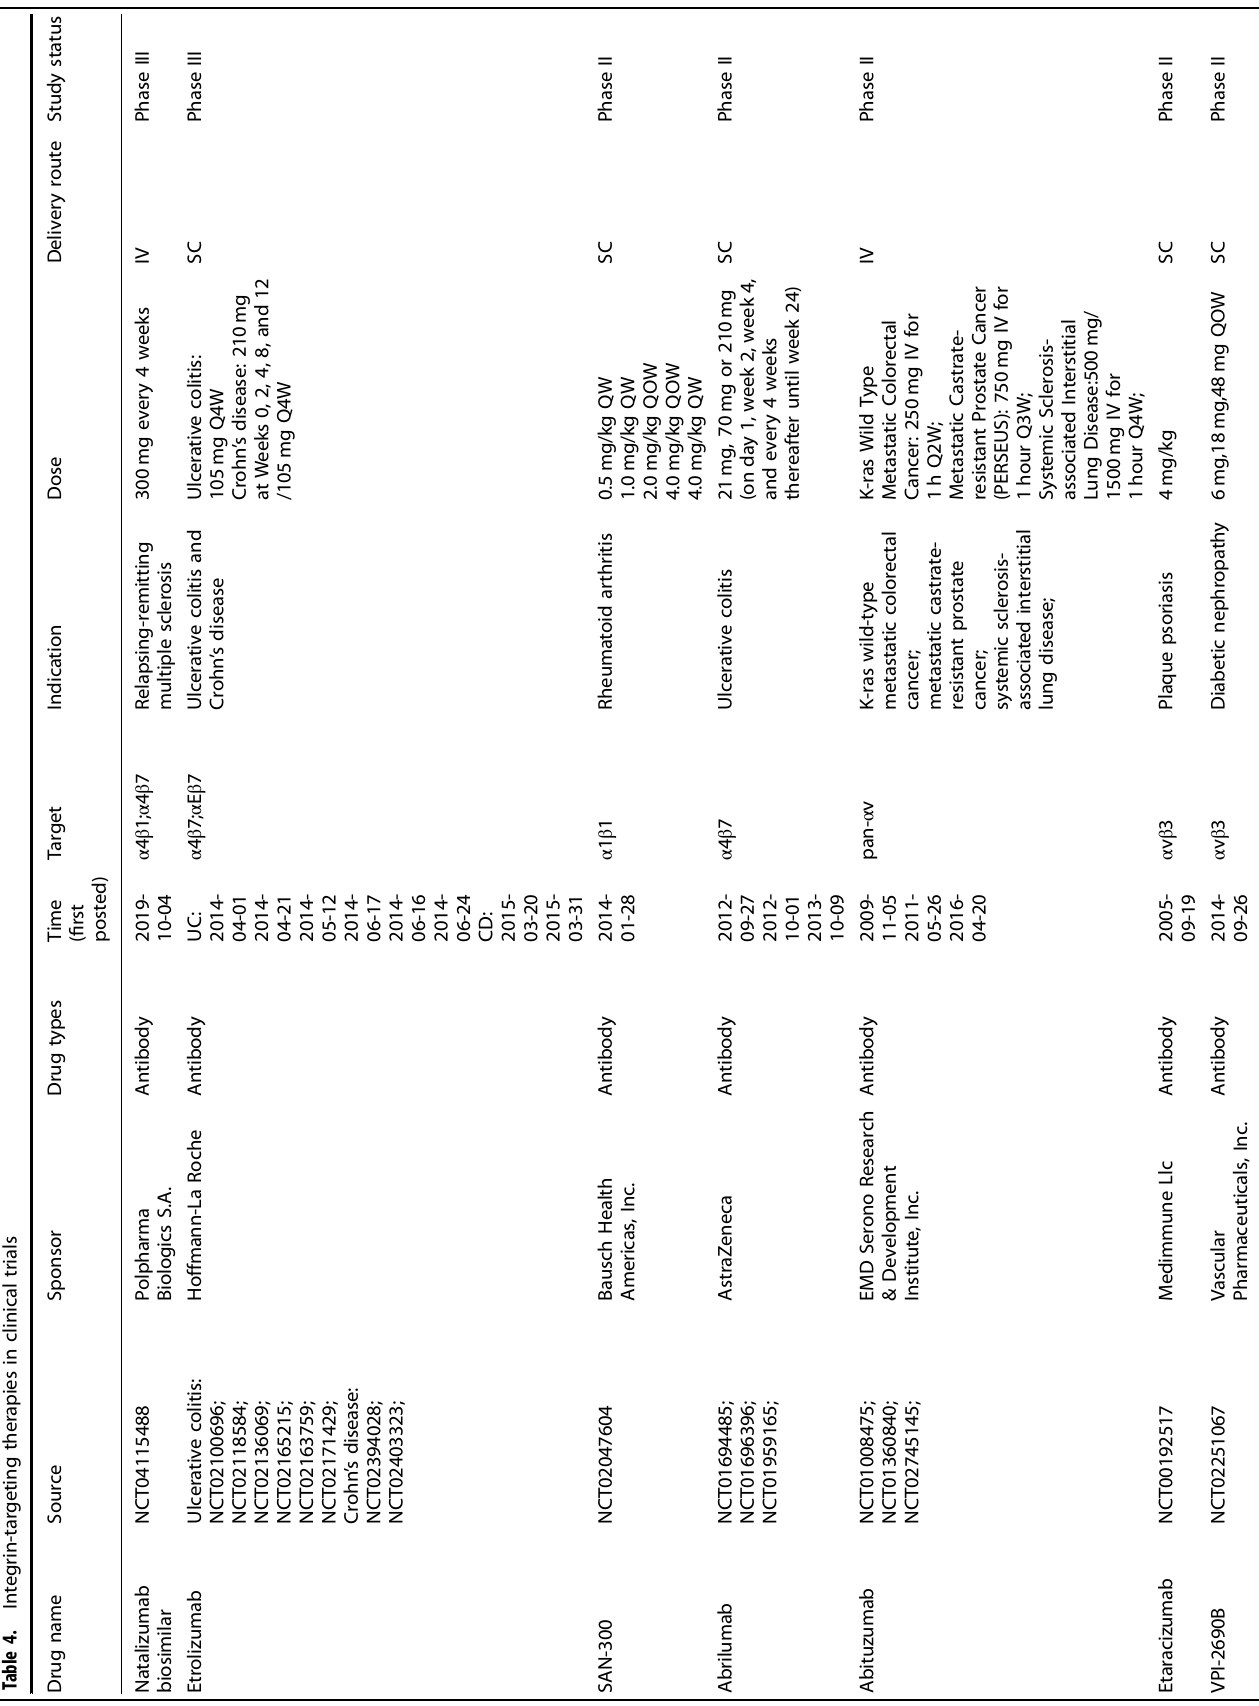
Signal Transduction and Targeted Therapy (2023)